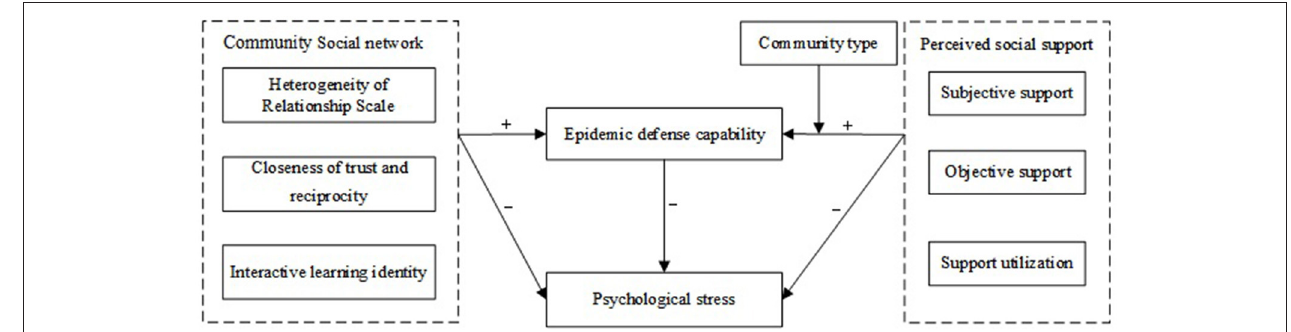
FIGURE 1 | Structural equation model